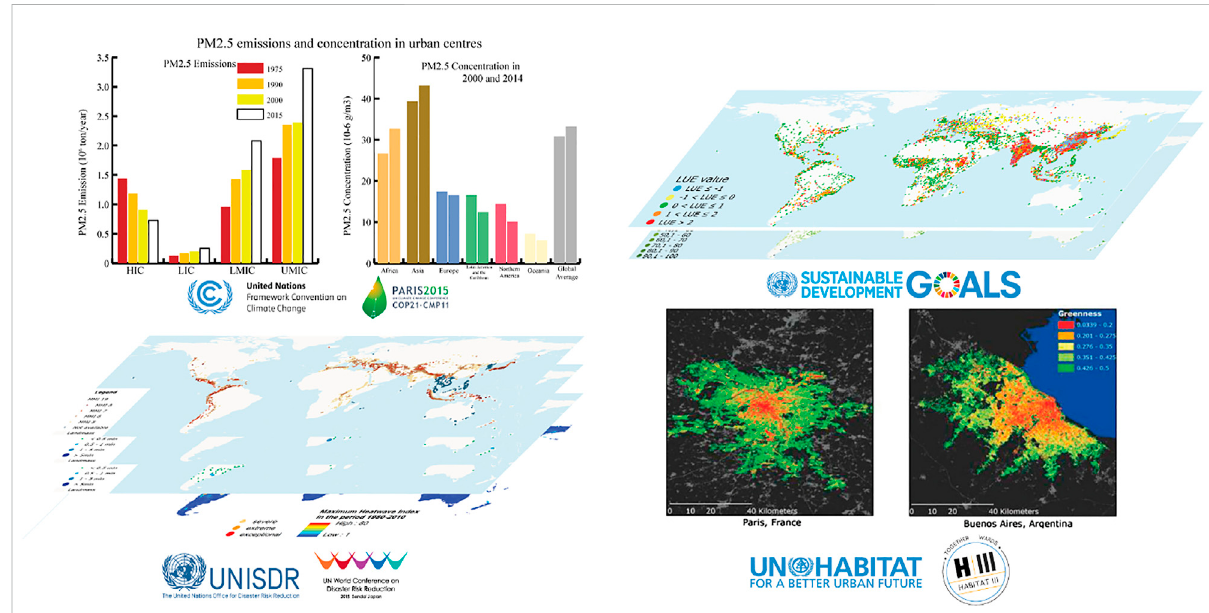
FIGURE 5 Examples of GHS-UCDB applications in service to the 2030 Development Agenda and thematic agreement. From top left, environment variables support the monitoring of pollutant emissions and concentrations in urban centres over time (serving the Paris COP21 agreement: UNFCCC); top right, land consumption to population growth rate (SDG 11.3.1); bottom right, access to green areas (proxy SDG 11.7.1) by the UN General Assembly and UNSDSN; bottom left, built-up areas and population exposure to natural hazards to support disaster risk reduction (Sendai Framework for Disaster Risk Reduction: